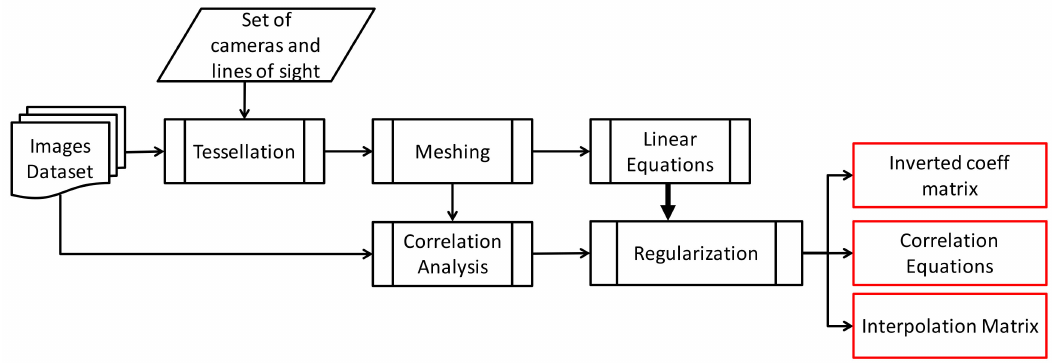
Figure 2. Offline procedure scheme. In red, the outputs provided to the online